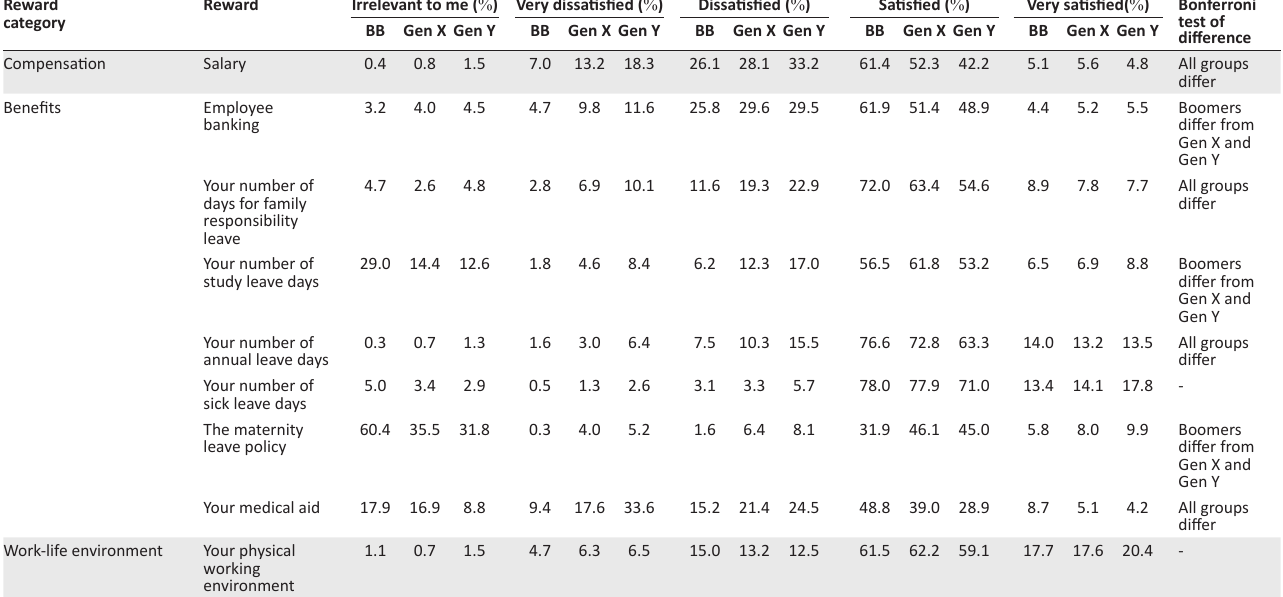
TABLE 12: The satisfaction levels of employees with regard to rewards received. Reward category